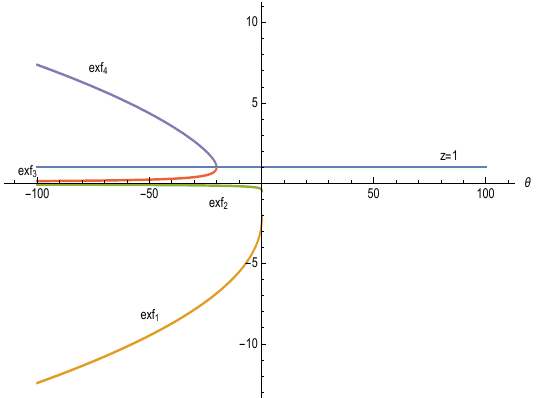
Figure 1. Behavior of the strange fixed